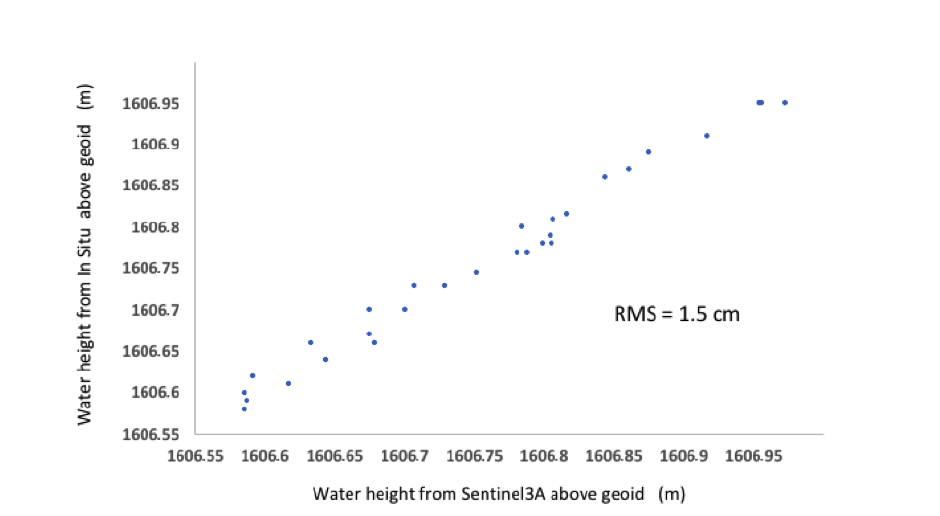
Figure 43. Scatter distribution of in situ water height from the historical gauges and the Sentinel-3A measurements. The RMS of the differences is 1.5